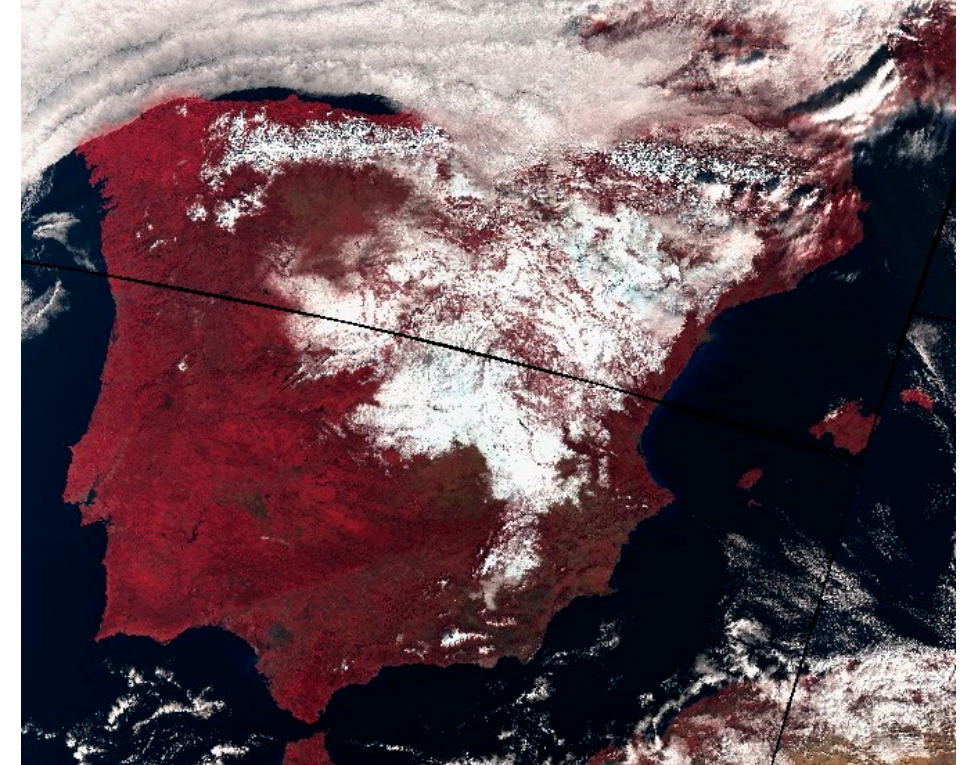
Figure 8. Quicklook of Sentinel-3 Sea and Land Surface Temperature Radiometer (SLSTR) S3/S2/S1 band combination for 12/01/2021. Image retrieved from https://www.sentinel-hub.com/, 25 May 2021.